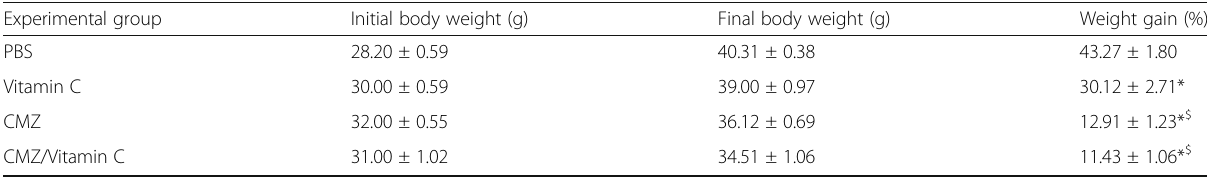
Table 1 Changes in body weight and percentage of body weight gain of male Swiss albino mice treated with PBS, vitamin C (1136 μ M/ kg), CMZ (46 μ M/kg), or a combination of CMZ and vitamin C with the same dose of each intraperitoneally (i.p.) daily over 4 weeks Experimental